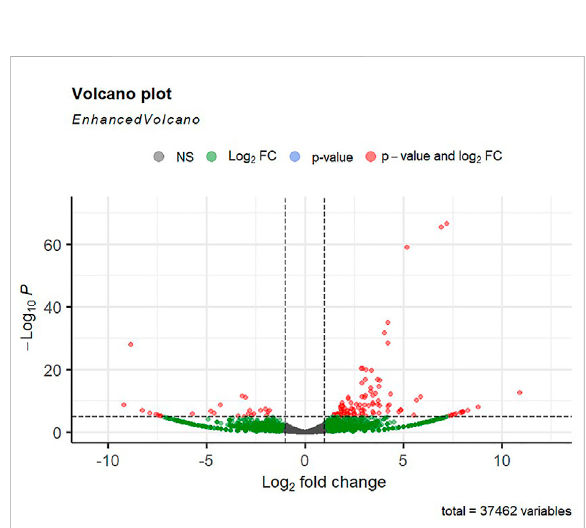
FIGURE 2 Volcano plot of differentially expressed genes identi fi ed between control and 2-ppt salinity group rohu fi sh. The X -axis signi fi es the Log2 fold change value, and the Y -axis indicates the − Log10 p value. The ash color dots indicate no signi fi cant difference between the two groups. The green dots indicate moderately signi fi cant and red dots highly signi fi cant differential genes.